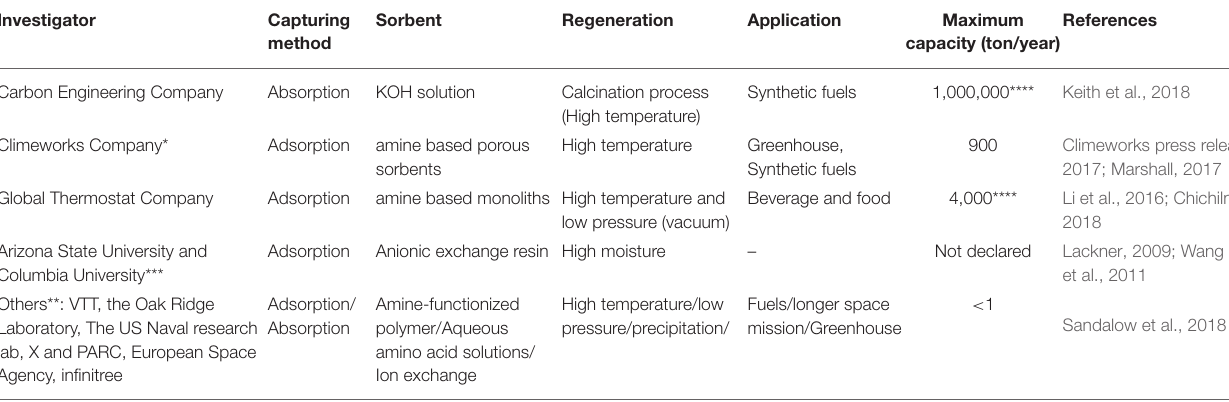
TABLE 1 | Major technologies on direct air